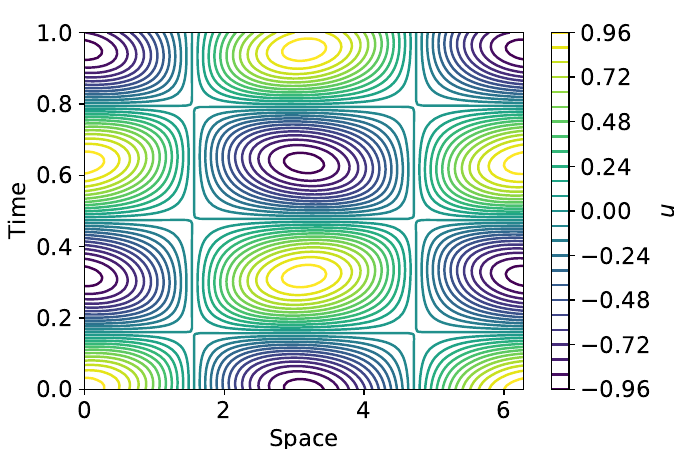
Figure 1. Results of wave equation PDE